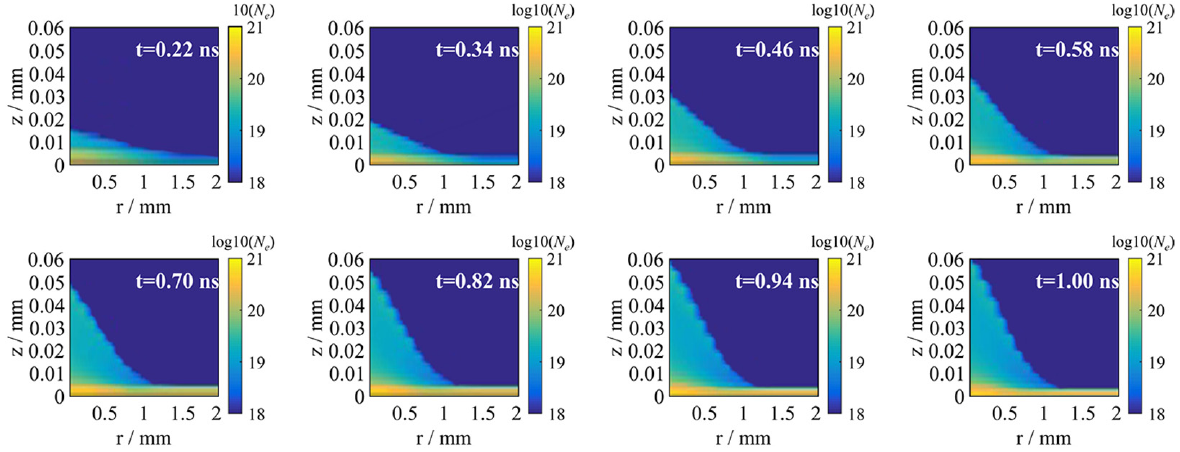
Figure 12. Simulation results of free electron concentration.